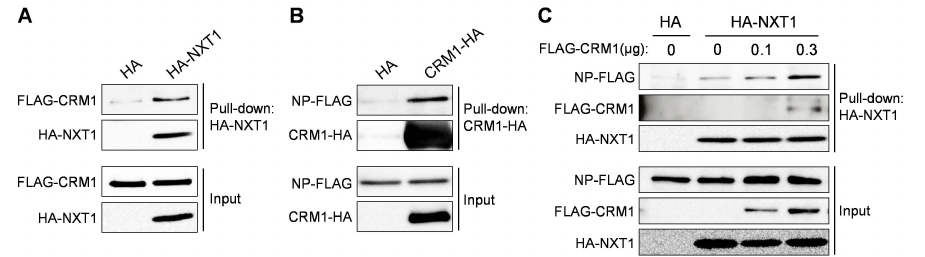
Figure 6. NXT1 forms a complex with NP and CRM1. HA-NXT1 or CRM1-HA protein was immobilized on anti-HA agarose beads. HA-NXT1 agarose beads were then co-incubated with purified FLAG-CRM1 protein ( A ) and CRM1-HA agarose beads were co-incubated with purified NP-FLAG protein ( B ) overnight at 4 ˝ C. The agarose beads were collected, washed, and subjected to WB analysis with anti-FLAG and anti-HA antibodies. Data shown are the results of one representative experiment from two independent trials; and ( C ) HA-NXT1 agarose beads were co-incubated with purified NP-FLAG and different amounts of purified FLAG-CRM1 proteins. The agarose beads were collected and subjected to WB analysis with anti-FLAG and anti-HA antibodies. Data shown are the results of one representative experiment from two independent trials.